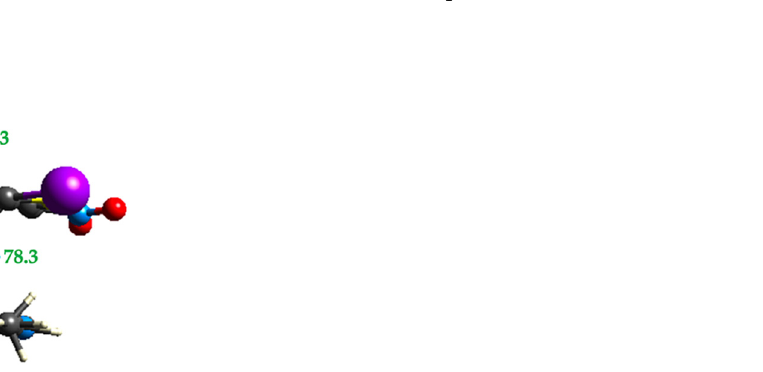
Figure 13. Complementary views of the two unique π -stacking interactions between three adjacent molecules within the cocrystal 2•3 .